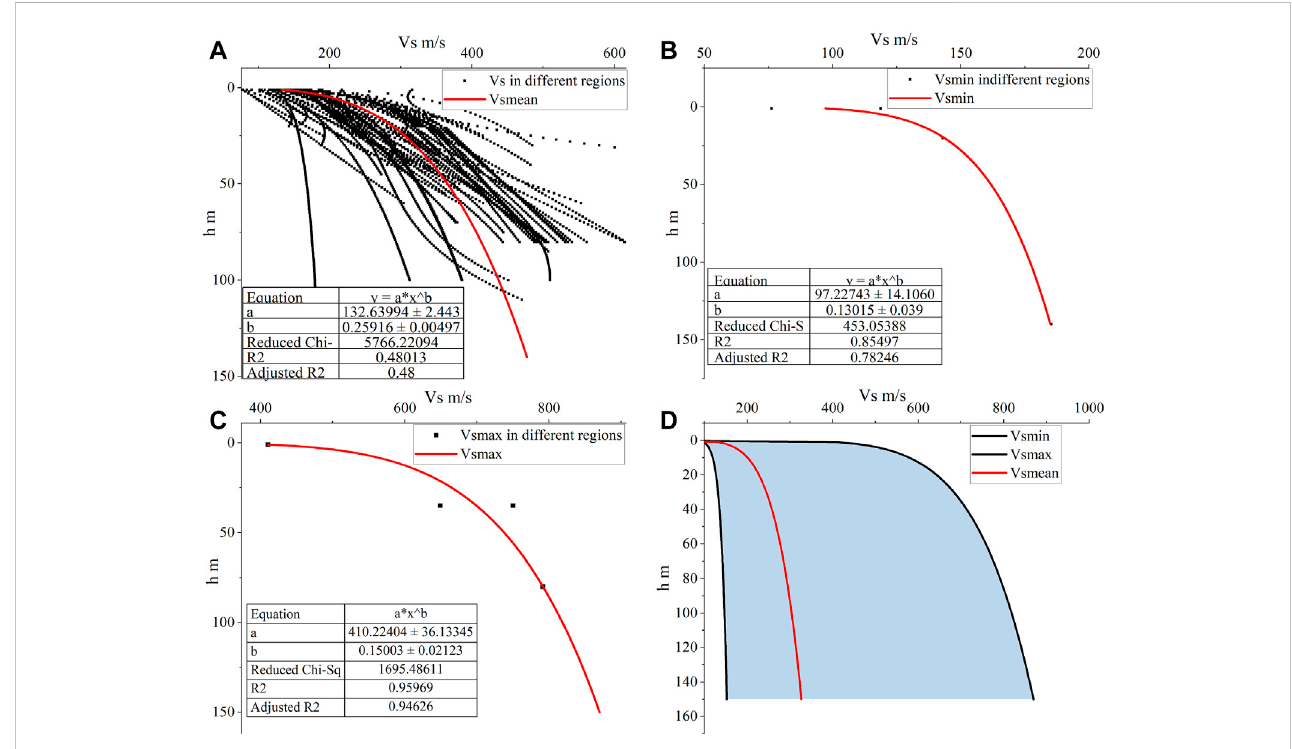
FIGURE 1 Fitting the empirical relationship between Vs and its burial depth in different